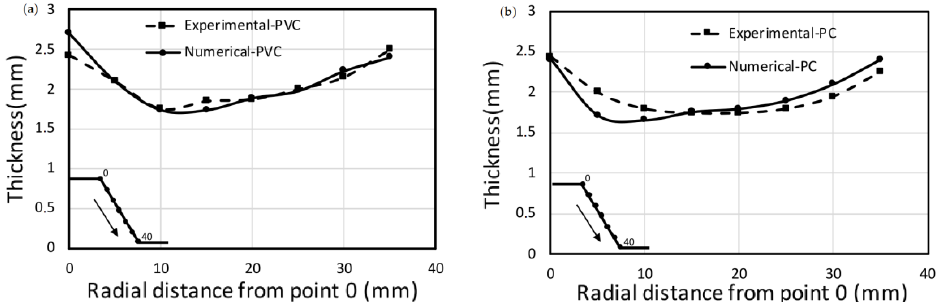
Figure 10. Thickness evolution respect to radial distance, ( a ) PVC and ( b ) PC. Process conditions: Cone shape, α = 60°, D = 10 mm and Δ z = 0.8 mm.